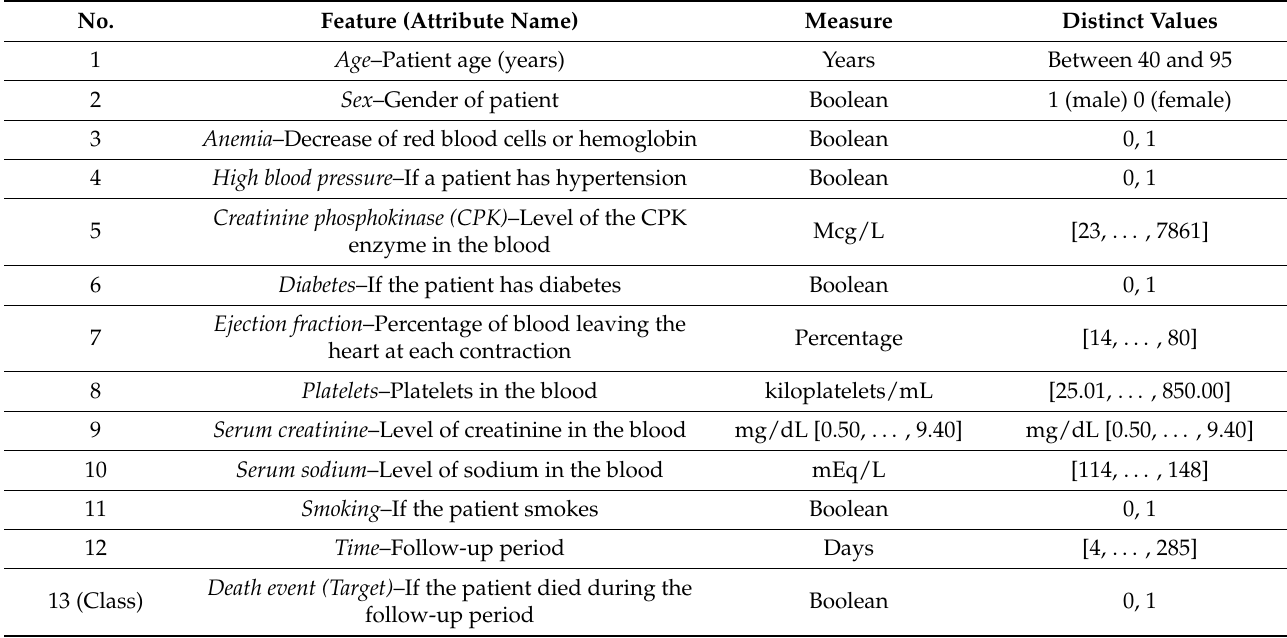
Table 6. CHD dataset.